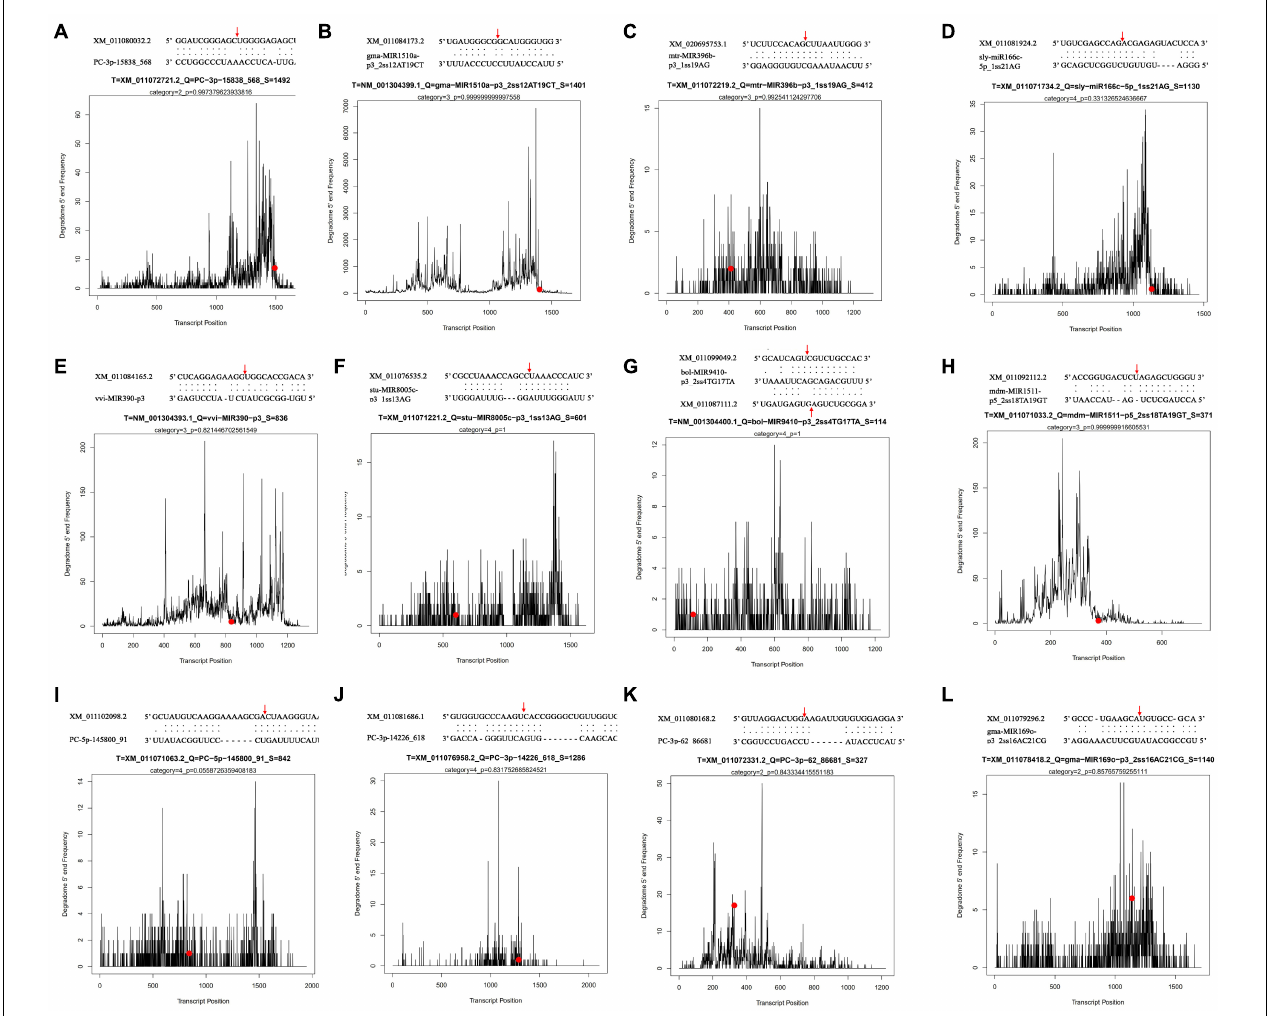
FIGURE 4 | Some differentially expressed miRNA t-plots and cleavage sites identified by degradome